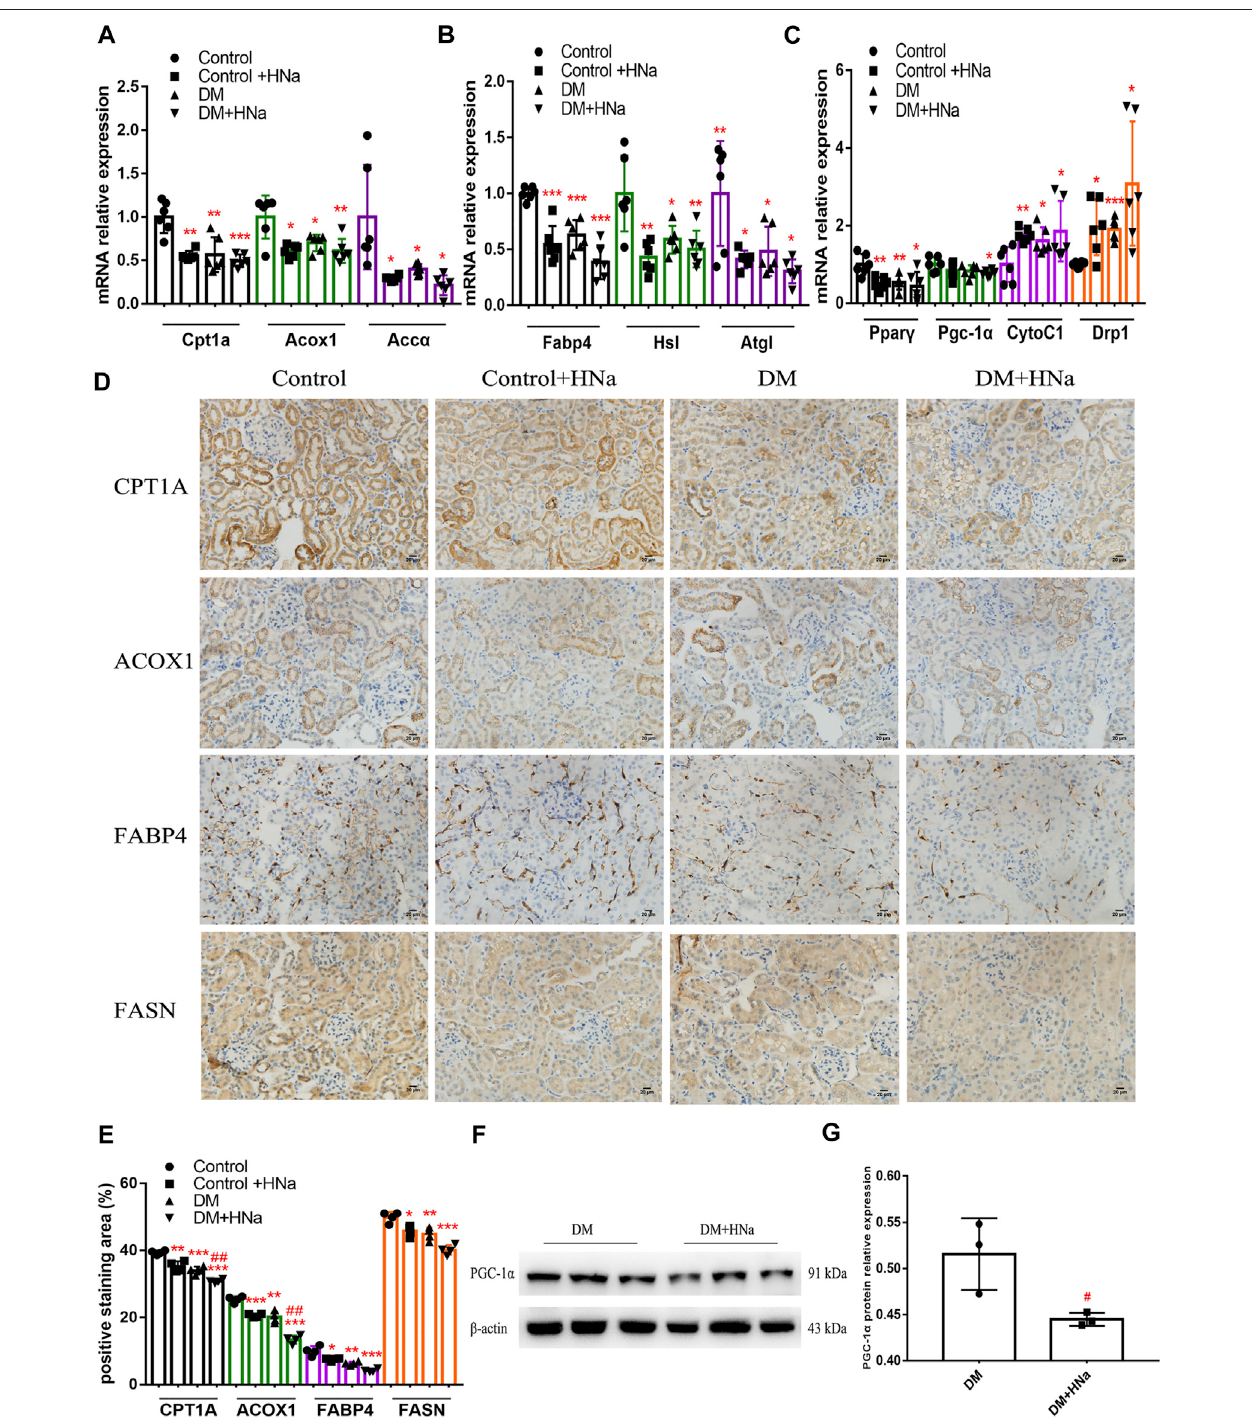
FIGURE 3 | High-salt diet alters the gene and protein expression pro fi le in renal tubules. Expression of genes involved in fatty acid metabolism (A,B) and mitochondrial biosynthesis (C) in renal tubules ( n (cid:1) 6 per group). (D) Paraf fi n-embedded renal sections were stained with CPT1A, ACOX1, FABP4 and FASN antibodies (magni fi cation, 400 × , bar (cid:1) 20 μ m). (E) Histopathological assessmentof CPT1A, ACOX1, FABP4 and FASN proteins ( n (cid:1) 4per group). PGC-1 α protein expression was detectedbywesternblot (F) with (G) relativedensityanalysis( n (cid:1) 3pergroup).Alldataaremean ± SEM,* p < 0.05,** p < 0.01and*** p < 0.001vs.Controlgroup;# p < 0.05 and ## p < 0.01 vs. DM group.